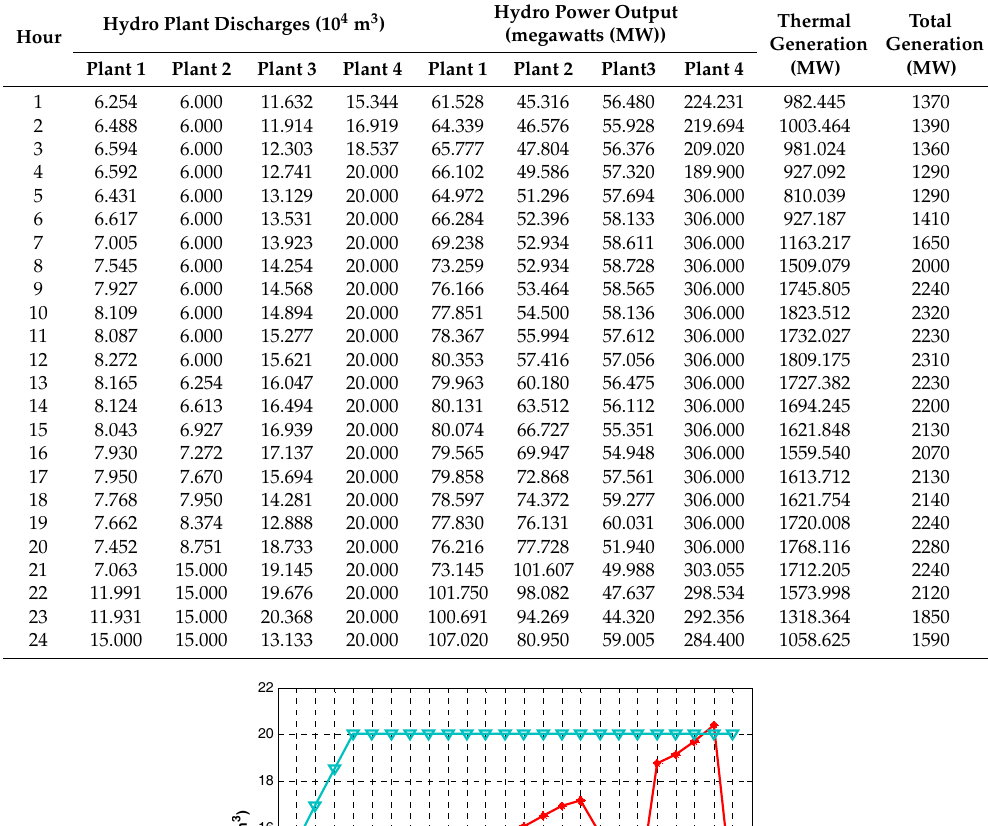
Table 1. Hourly plant discharges, power outputs and total thermal generation (test system 1, case 1).